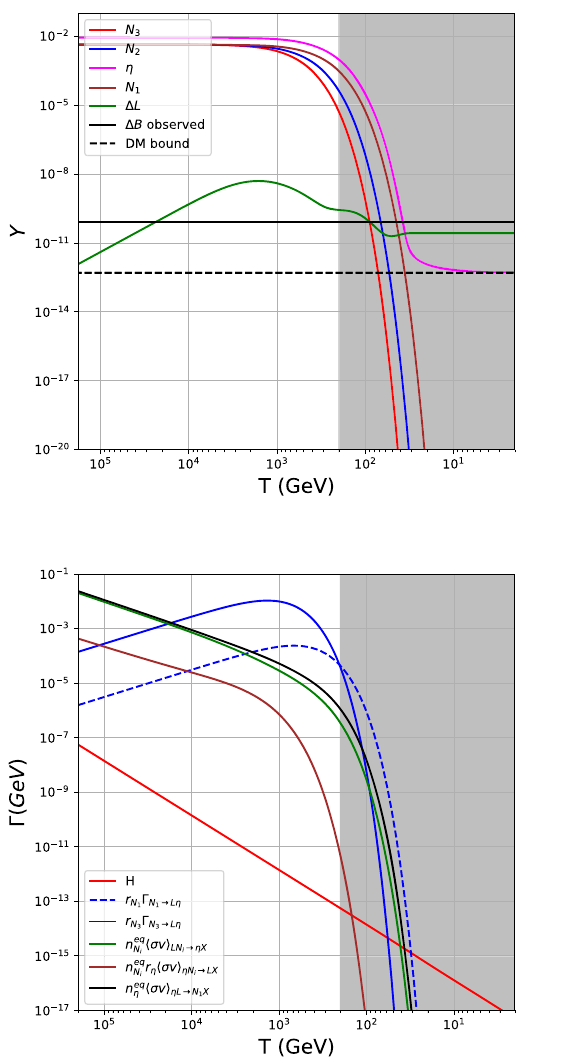
Fig. 3 Top panel: comoving number densities of Z 2 odd particles and lepton asymmetry as a function of temperature for scalar DM sce- nario. The left (right) panel corresponds to the normal (inverted) hier- archy of neutrino mass spectrum. Bottom panel: rates of individual wash-out processes along with the Hubble rate (left panel); individual